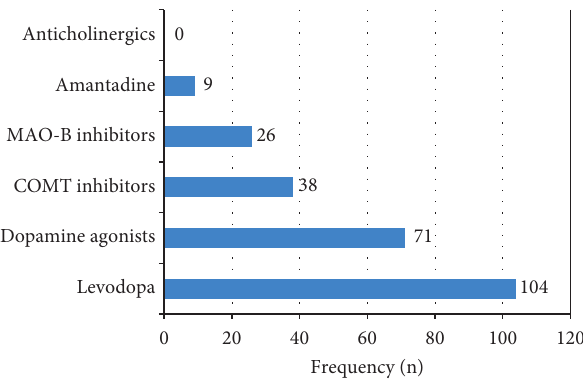
Figure 1: Number and classes of prescribed Parkinson’s disease medication ( N � 125).